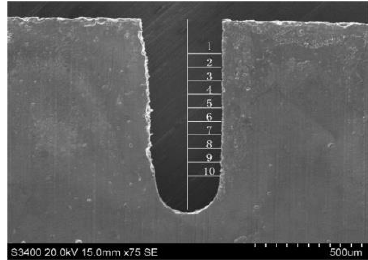
Figure 6. The measurement of unilateral slit width.